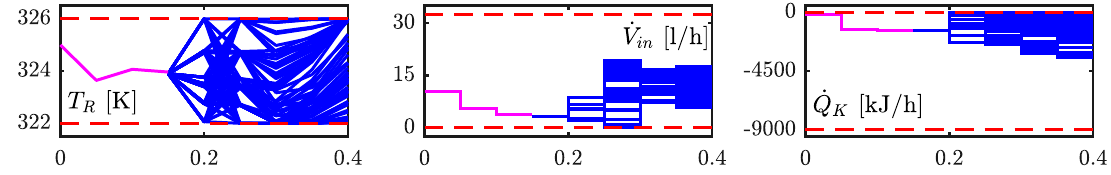
Figure 6. Reactor temperature, input feed, and jacket cooling power predicted in the scenario tree of the MS NMPC optimization problem solved at time t = 0.15 h. The magenta line ( ) indicates the measured plant state and control inputs applied to the plant in the past, the blue lines ( ) indicate the predicted plant states and control inputs and the dashed red lines ( ) indicate the